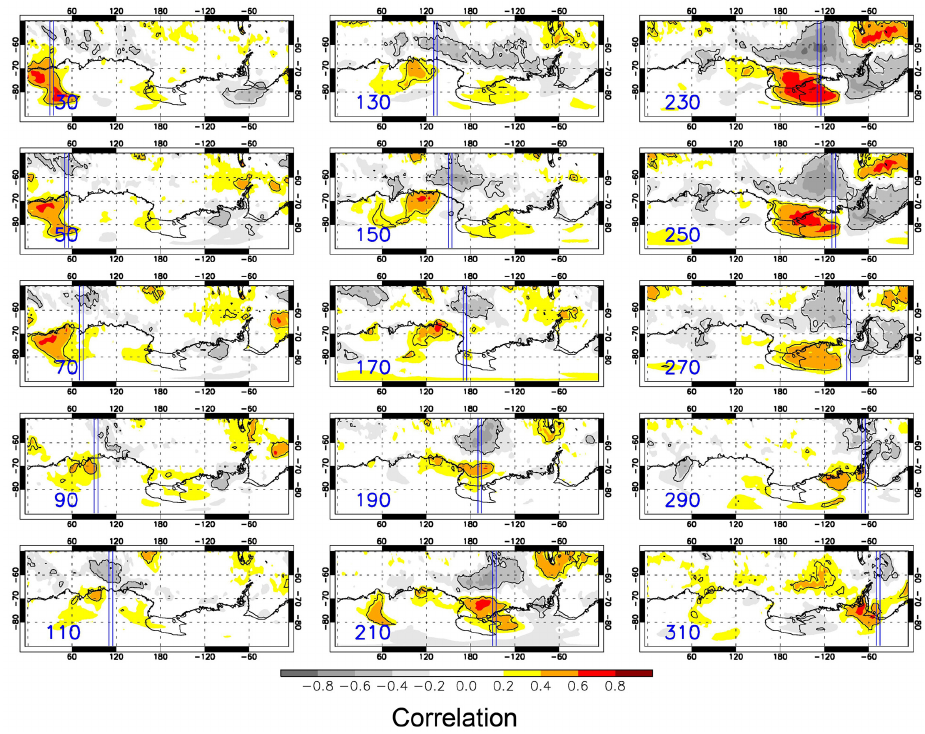
Fig. 7. Spatial correlation between the cumulative annual ERA INTERIM snowfall and cumulative annual blocked days, calculated as in Scarchilli et al. (2011), for different longitudinal sectors (blue vertical lines and numbers represent the sectors involved in the correlation). The black lines enclose correlation values significant larger than